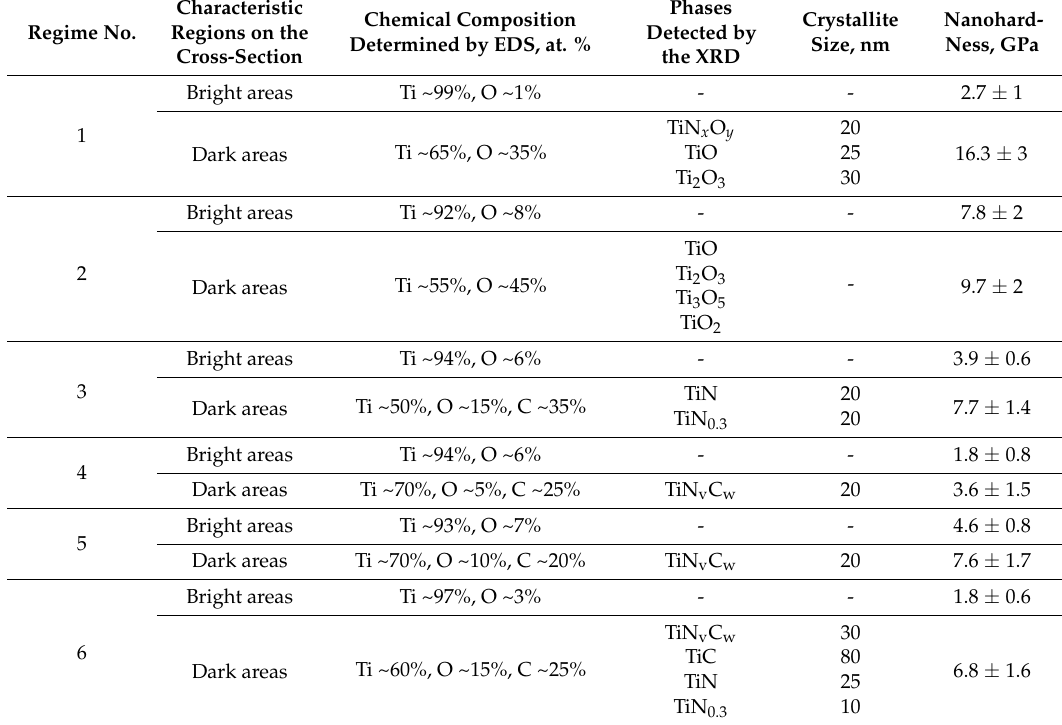
Table 3. Microstructure characteristics and nanohardness of the coatings detonation sprayed under various regimes.